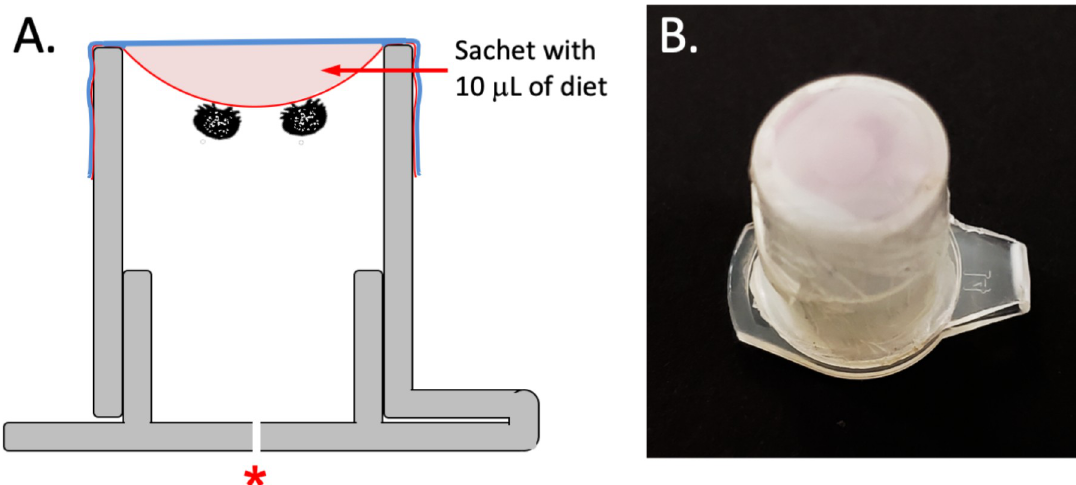
Fig 1. Details of the device and membrane sachet comprising the in-vitro system used for maintaining Varroa mites during experiments. (A). Diagram showing the design of the device housing the mites, as modified from a snap-cap 1.5 mL microcentrifuge tube. The arrow shows parafilm membrane sachet with diet. A red asterisk indicates a hole in the lid for air pressure relief. Two mites are shown attached to the inner membrane to feed on the diet. (B) Photo of the complete system, comprising the device housing the mites and attached parafilm membrane sachet filled with 10 μ L of artificial diet